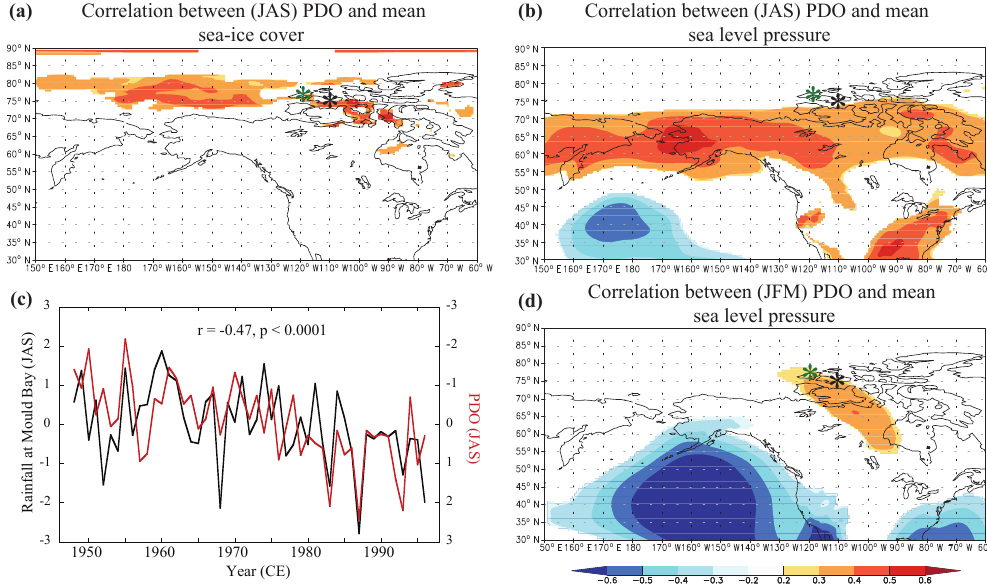
Figure 1. PDO modulation of western Canadian Arctic climate. (a) Correlation between PDO (Huang et al., 2015) and sea-ice anomalies from ERA-Interim (Dee et al., 2011) for July–September during 1979–2016. (b) Same as (a) but for mean sea level pressure from ERA- Interim (Dee et al., 2011). (c) Comparison between the time series of rainfall at Mould Bay and PDO during July–September. (d) Same as (b) but for January–March (JFM). Black and green asterisks denote Cape Bounty and Mould Bay weather stations respectively. Note that Mould Bay weather station stopped operating in